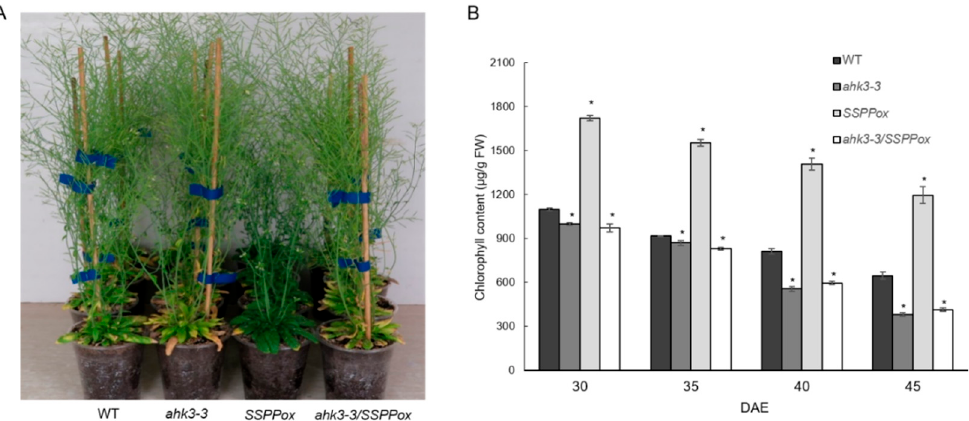
Figure 1. Loss of AHK3 reversed the delayed leaf senescence mediated by SSPP. ( A ) The 59-day-old ahk3-3 , 35S:SSPP ( SSPPox ), ahk3-3 / SSPPox and wild-type (WT) control Arabidopsis were photographed. ( B ) chlorophyll contents in the sixth leaf of ahk3-3 , SSPPox , ahk3-3 / SSPPox , and wild-type control Arabidopsis were determined at 30, 35, 40 and 45 days after emergence (DAE). FW, fresh weight. Three biological replicates with at least three technical repeats were done. Error bars represent standard